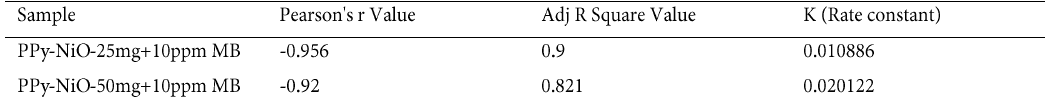
Table 3. Rate constant calculations for 25 mg and 50 mg NiO-PPy hybrid composites.